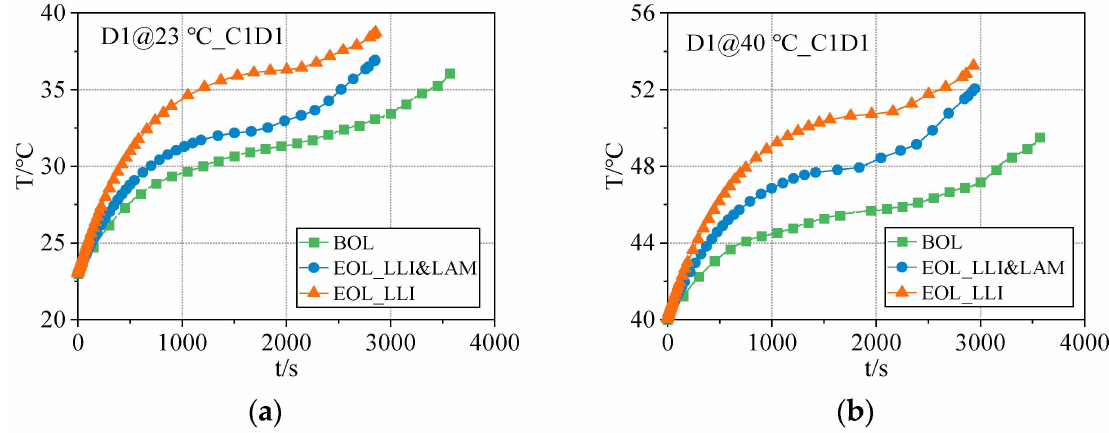
Figure 21. The comparison of the surface temperature rises during the discharging process when the cell ages to EOL under different aging modes at ( a ) 23 °C and ( b ) 40 °C.